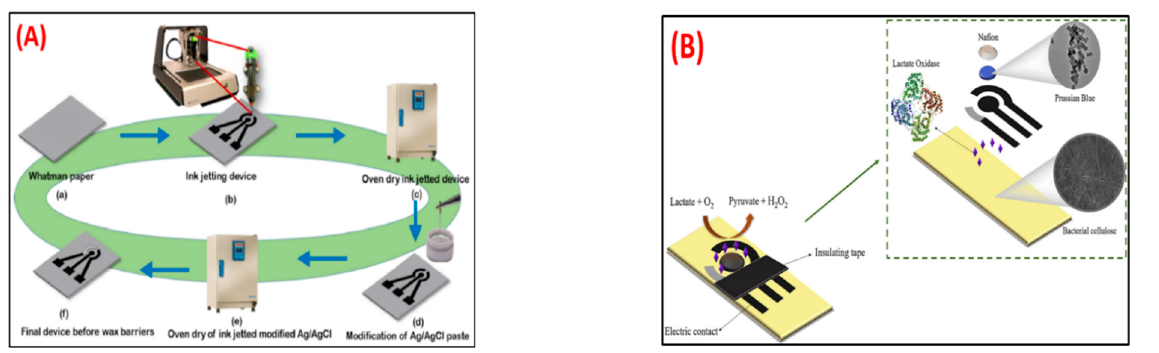
Figure 8. ( A ) Optimized ink-jetted paper device for electroanalytical detection of picric acid [114]. ( B ) Bacterial cellulose-based electrochemical sensing platform for miniaturized biosensors [115]. Reprinted from the above-mentioned references with the permission of copyright from the respec- tive journals.